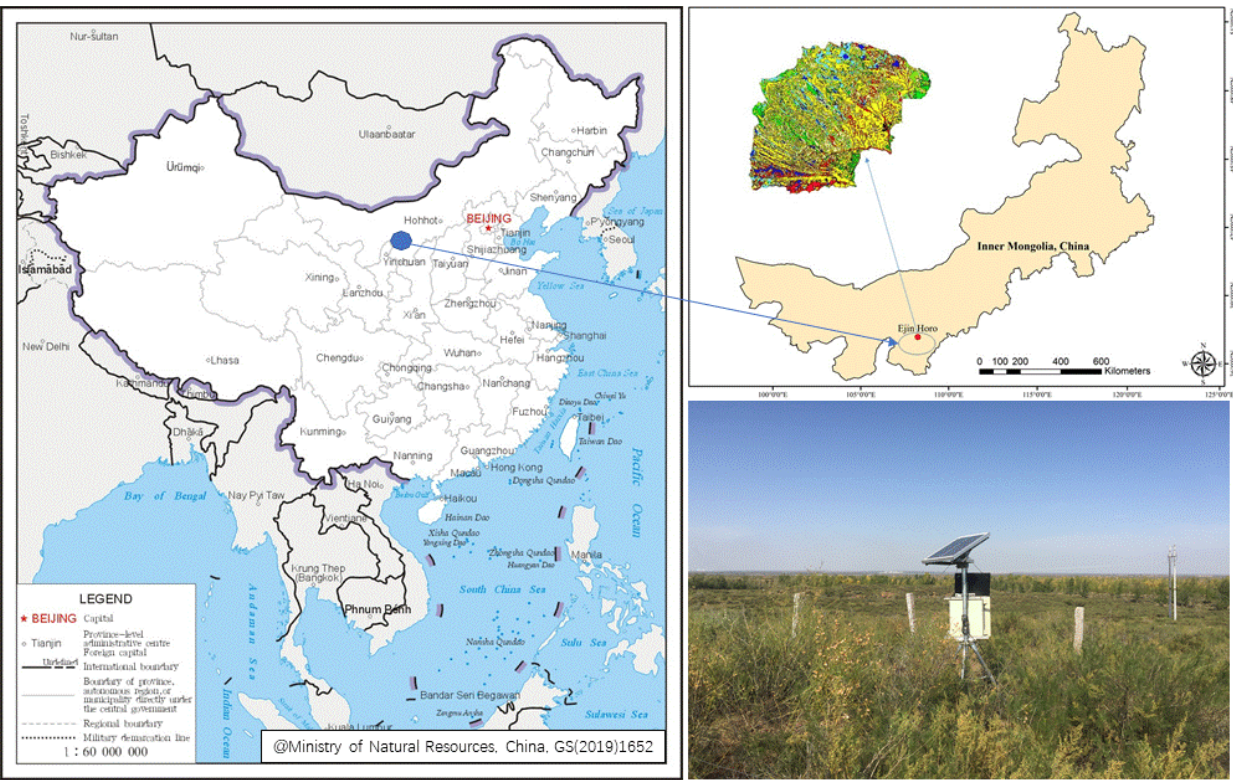
Figure 1. Overview of the experimental